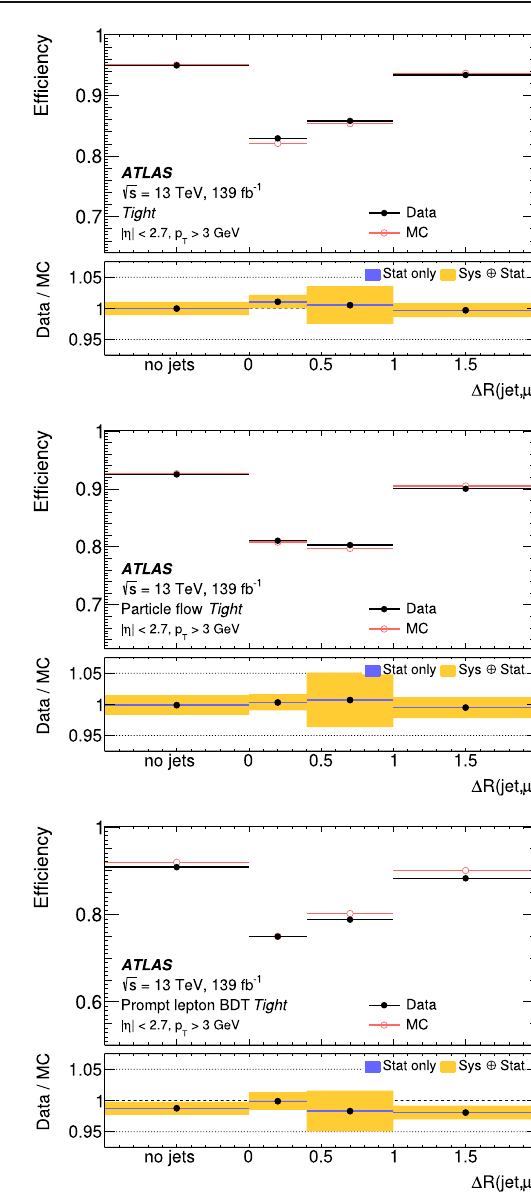
Fig. 20 Muon isolation efficiency measured in Z → μμ events for the Tight (top plots), PflowTight (middle plots), and PLBDTTight (bot- tom plots) criteria, as a function of p T (left plots) and (cid:8) R ( jet ,μ) (right plots) for muons with p T > 3 GeV. The statistical uncertainty in the